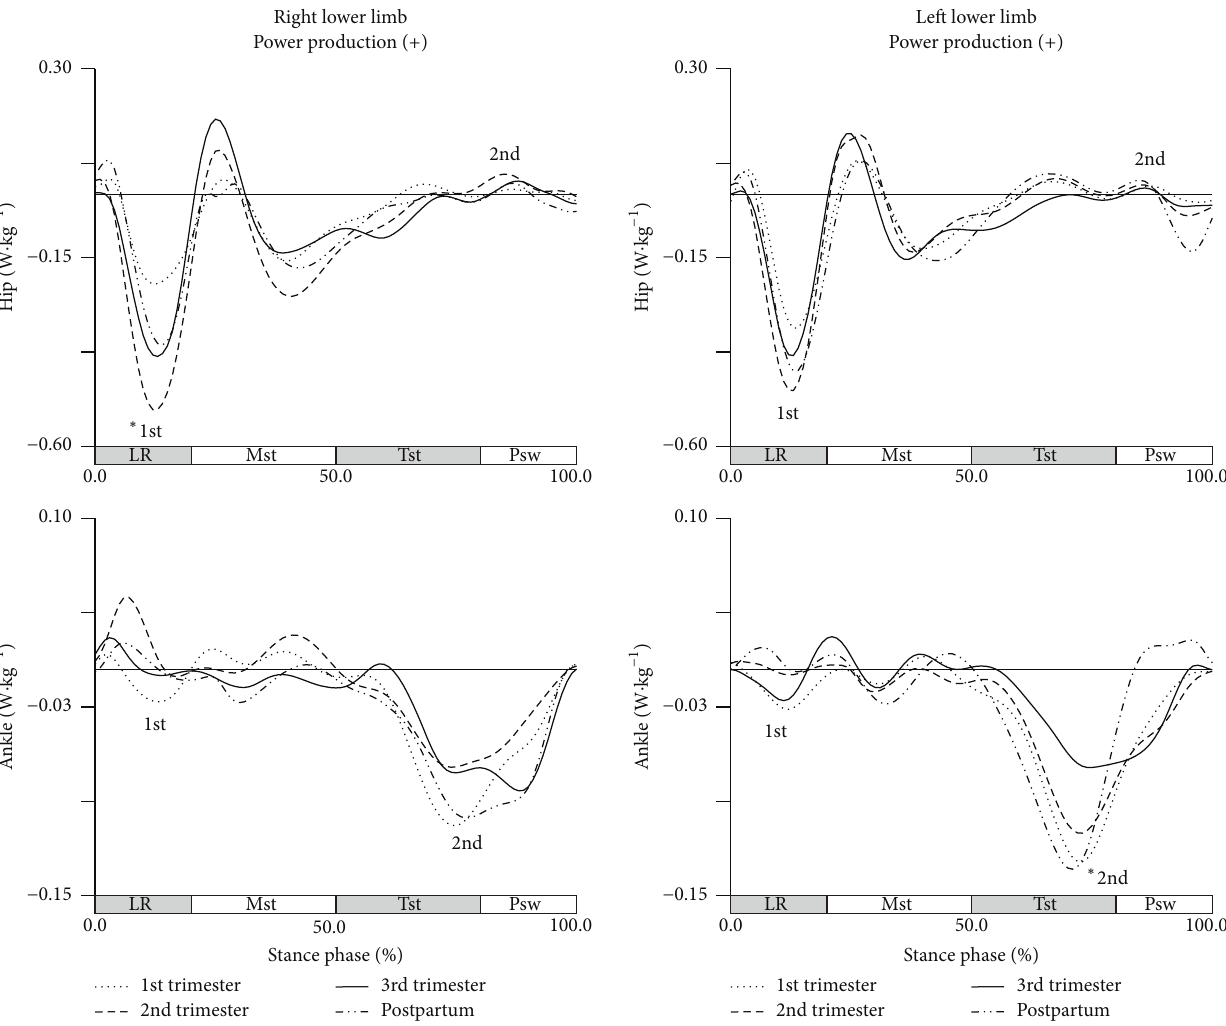
Figure 7: Joints power in the transverse plane during gait (in W ⋅ kg −1 ). Each line represents the later stages of first (dotted line), second (dashed line), and third trimesters (solid line) and of postpartum period (dash-dot-dot line). Mean joint powers of the hip and ankle, for right and left lower limbs. The curve peaks are indicated by numbers: 1st, 2nd, 3rd, and 4th, and ( ∗ ) points the significant